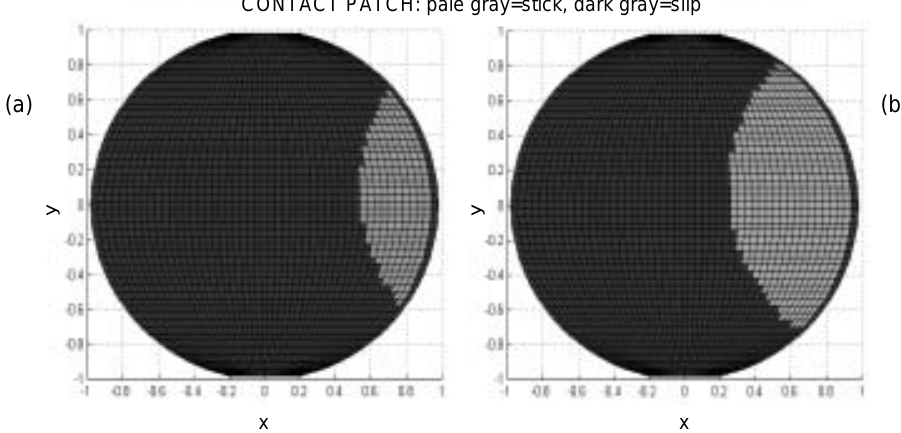
Fig. 8. Adimensionalized contact patches taken into account by FASTSIM for the computation of the tangent contact forces. Only the wheelset mass is considered; (a) Vehicle on rails; (b) vehicle on rollers.